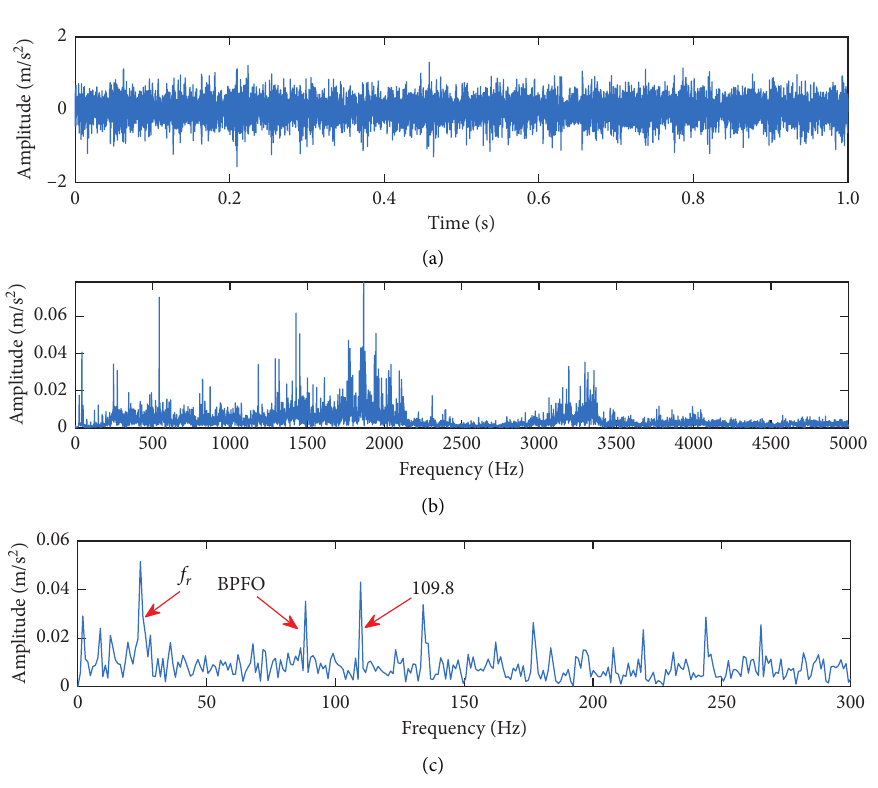
Figure 18: Experimental signals of case 1: (a) time-domain waveform, (b) frequency spectrum, and (c) squared envelope spectrum.